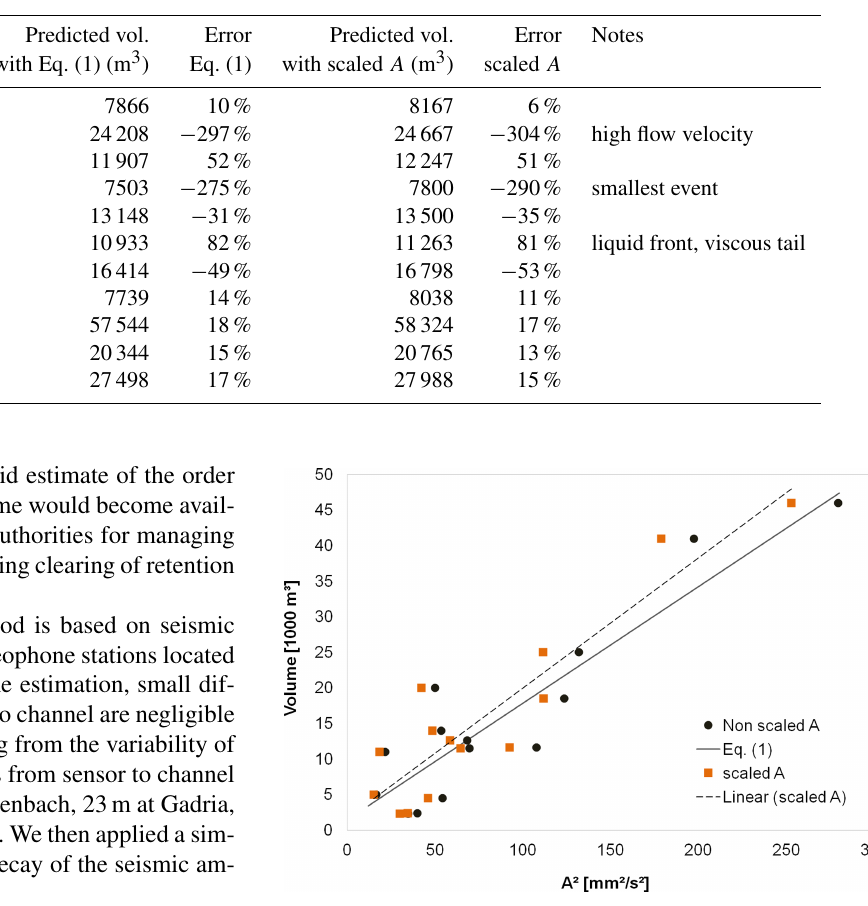
Table 3. Errors in the volume prediction for the Illgraben test dataset.